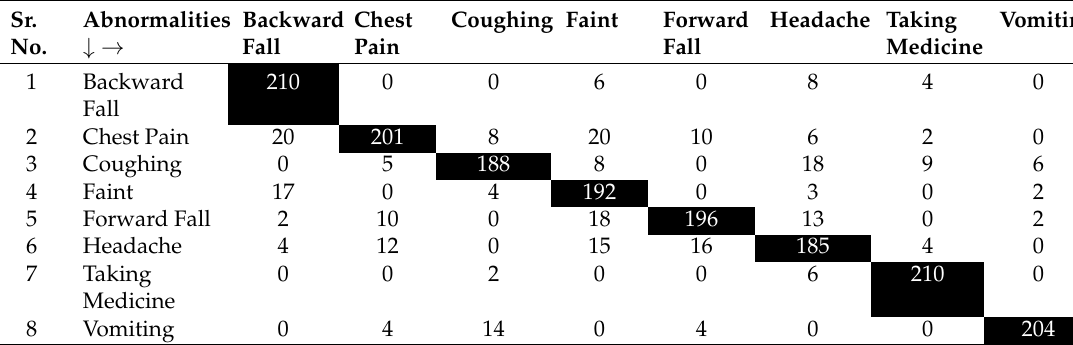
Table 6. Confusion matrix of dataset with the ratio of 60:40.